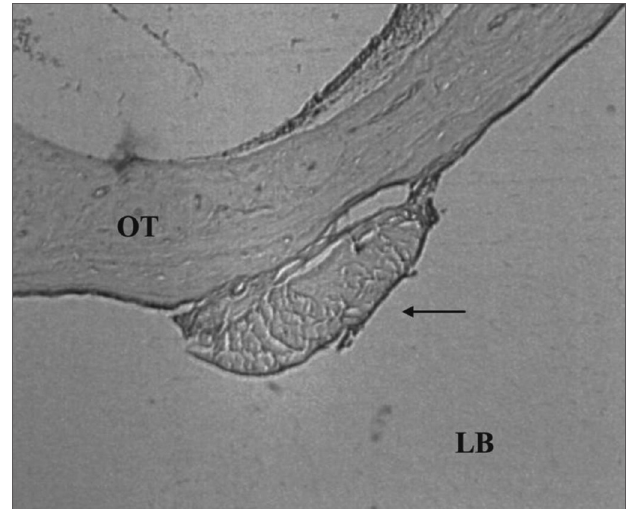
Figure 6. Control Group. Microphotography of the fascia adhered to the tympanic bulla mucosa. LB= bulla lumen; OT = Temporal bone; thin arrow= fascia. HE (100x